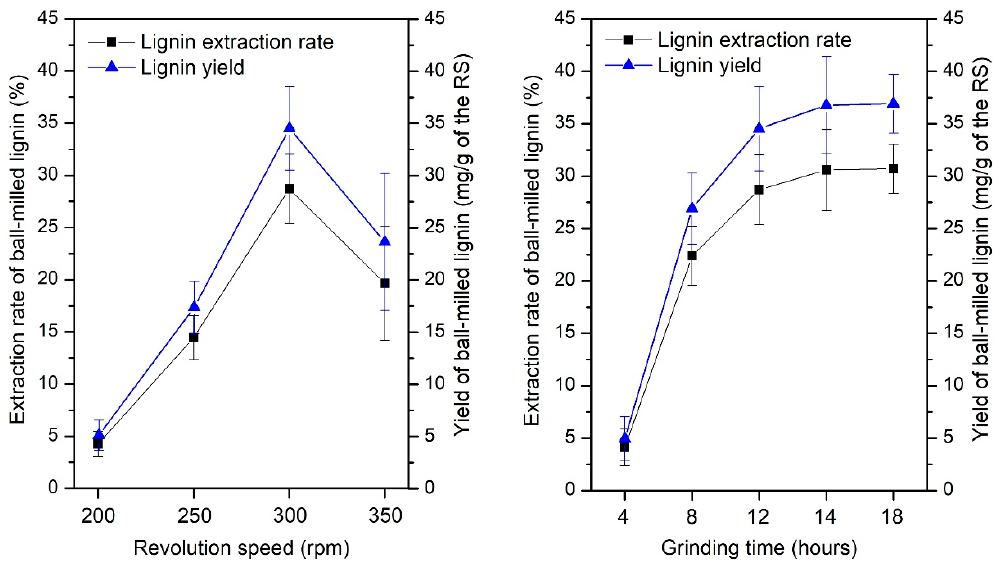
Figure 1. The effects of revolution speed and grinding time on the extraction rate and yield of ball-milled lignin.